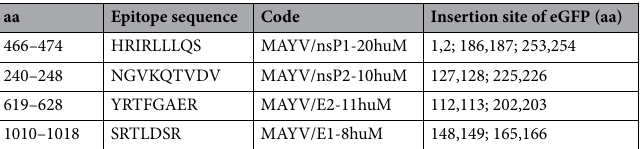
Table 1. Selected epitopes mapped in MAYV proteins using a pool of sera from patients with mayaro